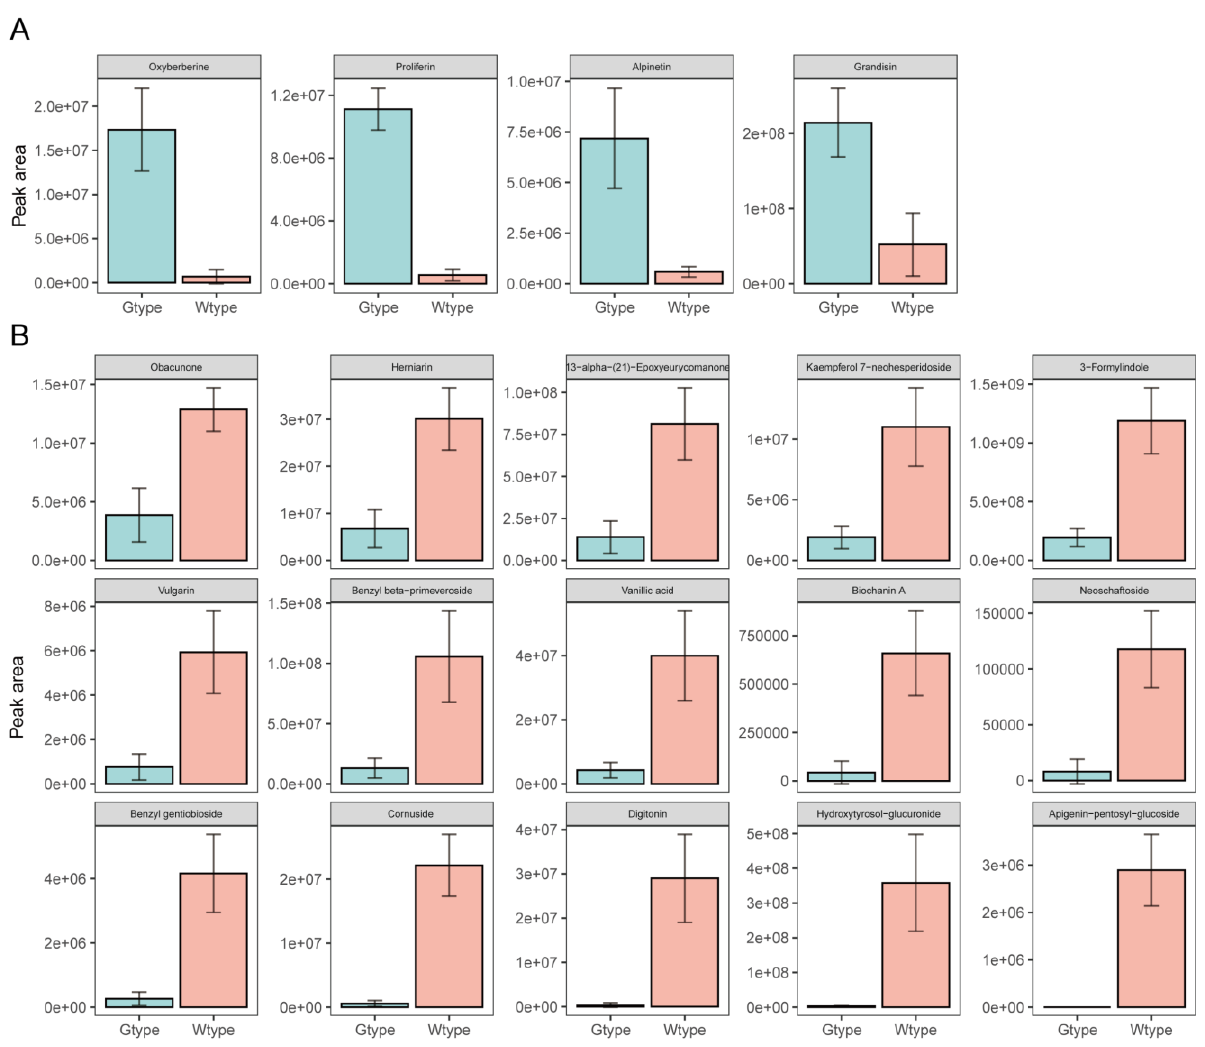
Figure 6. The comparison of the peak areas of the 19 differentiating metabolites belonging to phenolic compounds, terpenoids, and alkaloids, between the two types of P. sibiricum. ( A ) The metabolites that are significantly higher in the Gtype samples; ( B ) the metabolites that are significantly higher in the Wtype samples.